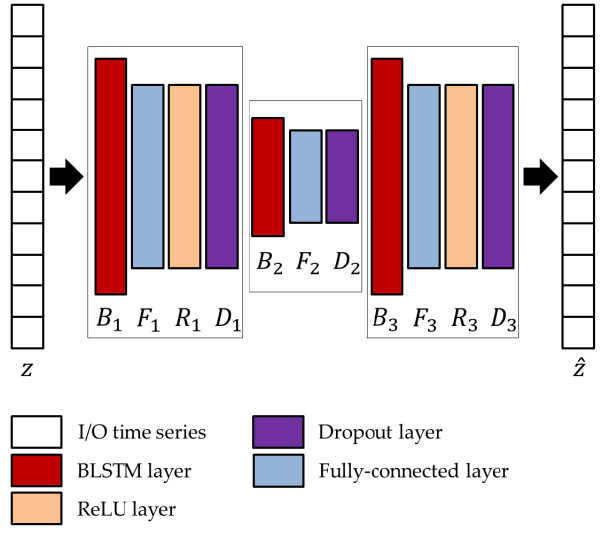
Figure 7. Architecture of the BLSTM-AE network adopted in conjunction with the TCN. Table 5. Optimized parameters of the network architecture shown in Figure 7.